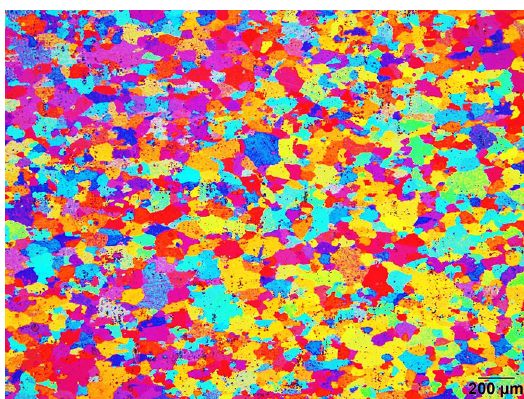
Figure 14. Microstructure of overaged AA 7075 after cold-rolling (75% in thickness reduction) and annealing (400°C and 1 hour). Obtained by using polarized light